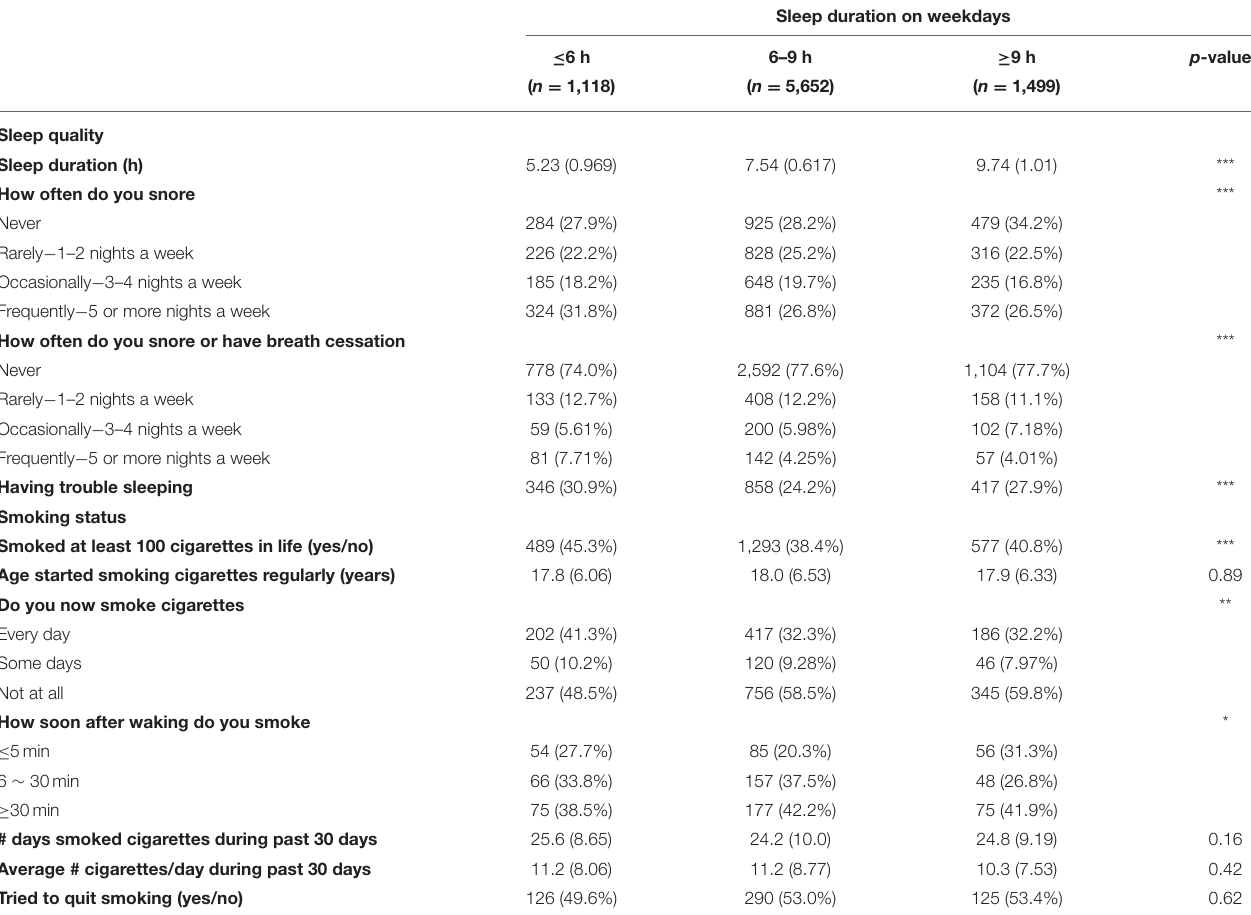
TABLE 4 | Sleep quality and smoking characteristics of study population grouped by sleep